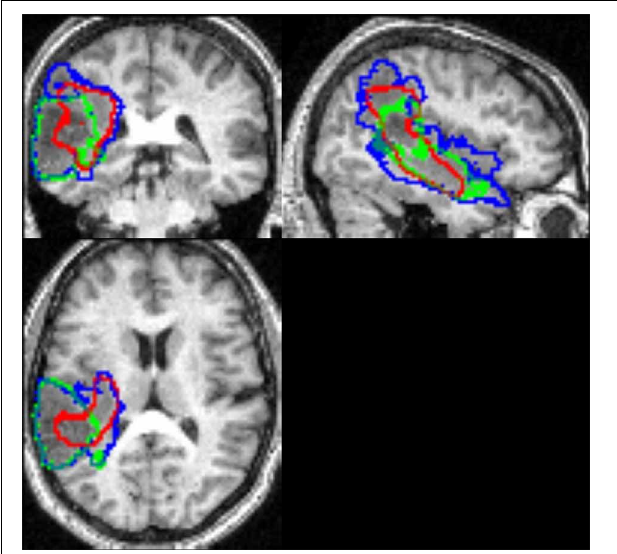
FIGURE 5 | The tumor contour for Patient 18 identified by recursive ALI in red, Observer 1 in blue, and Observer 2 in green. This illustrates inconsistency between observers and the areas missed by the recursive ALI procedure (e.g., in the parieto-temporal